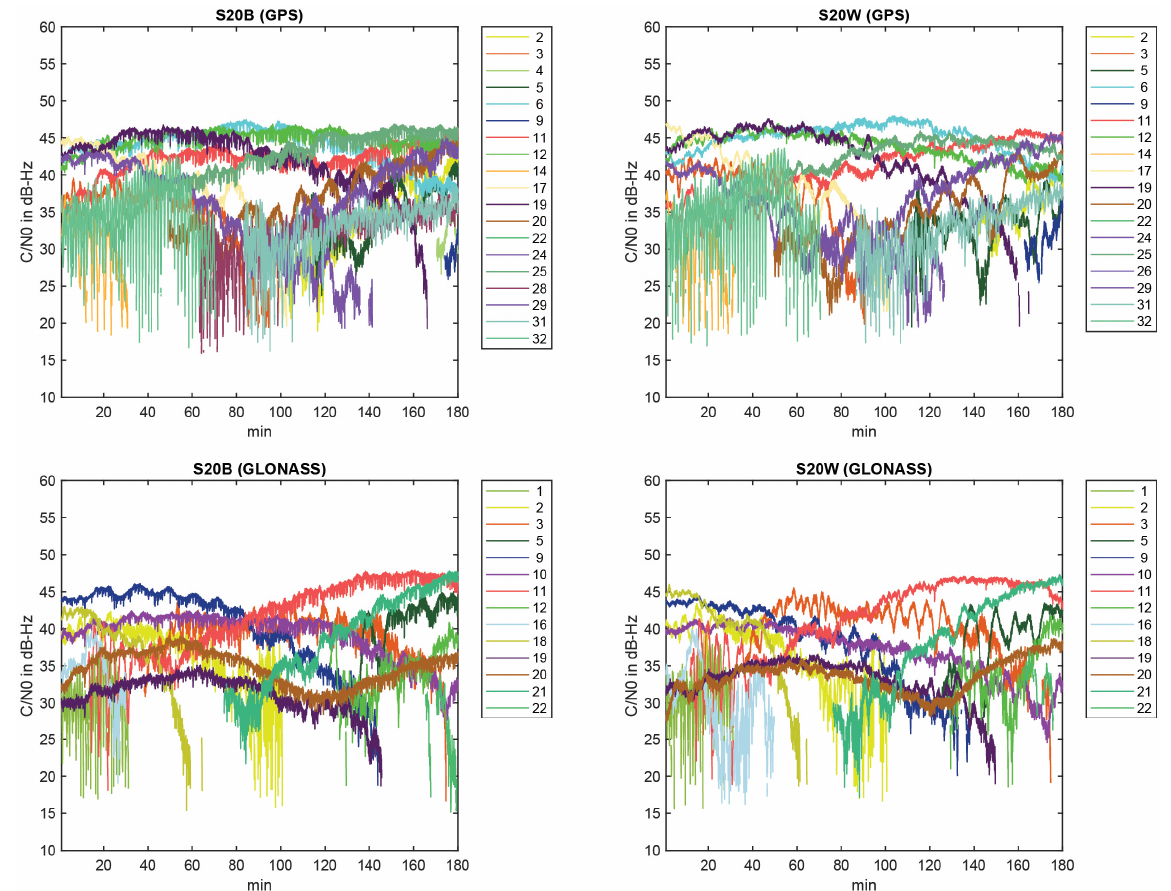
Figure 3. C/N0 values for GPS and GLONASS on the first frequency for both devices.